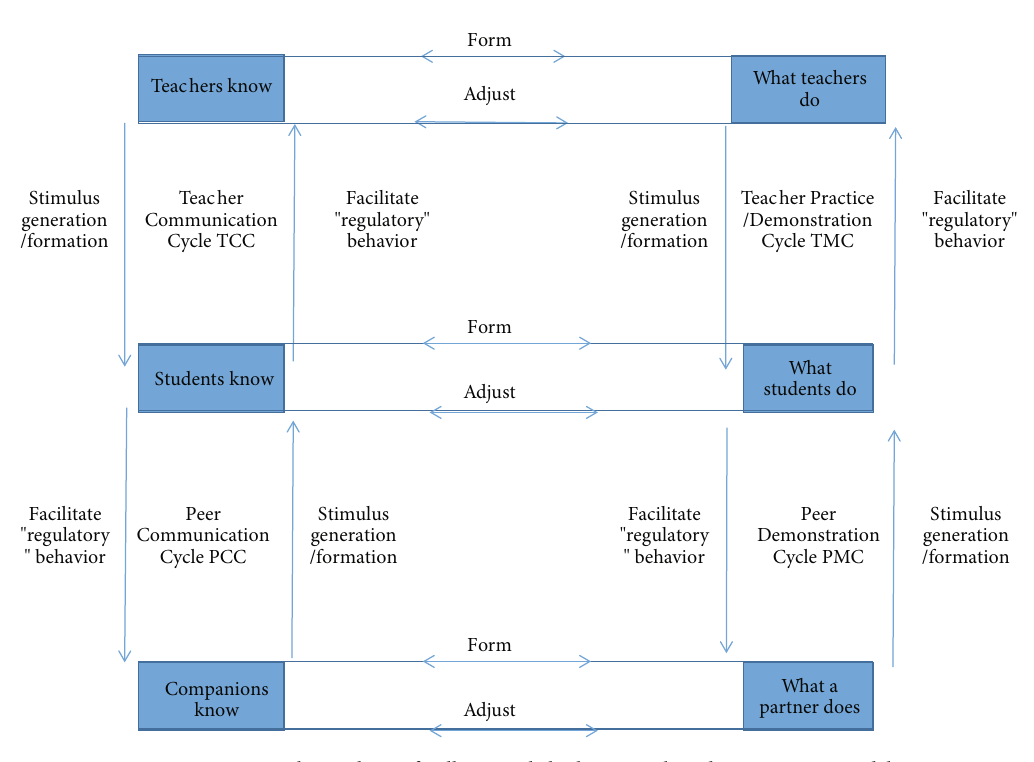
Figure 13: BOPPPS model preparation before class.